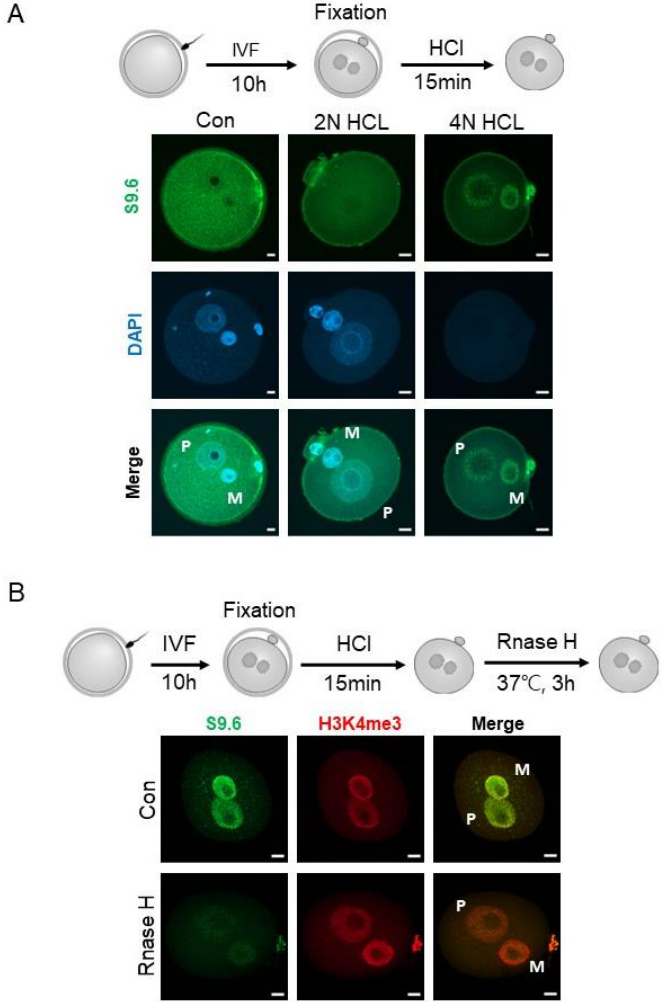
Figure 1. Optimization of R-loop immunofluorescence. ( A ) Maximum intensity projection of z-stack images of 10 hpi zygotes. Immunofluorescence detection of the R-loop using S9.6 antibodies. DNA denaturation steps were used for antigen retrieval using the 2N or 4N HCl for 15 min. Images show the R-loop (S9.6 antibodies, green), DNA (DAPI, blue), and merged image of these two channels (merge). ( B ) Maximum intensity z-stack projection images of 10 hpi zygotes. Immunofluorescence detection of the R-loop (S9.6 antibodies, green), histone H3K4me3 (red), DNA (DAPI, blue), and merged images of these three channels (merge) in zygotes that were mock-treated or treated with 80 IU/mL of RNase H for 3 h at 37 °C. M, maternal pronucleus; P, paternal pronucleus. All scale bars = 10 µM.